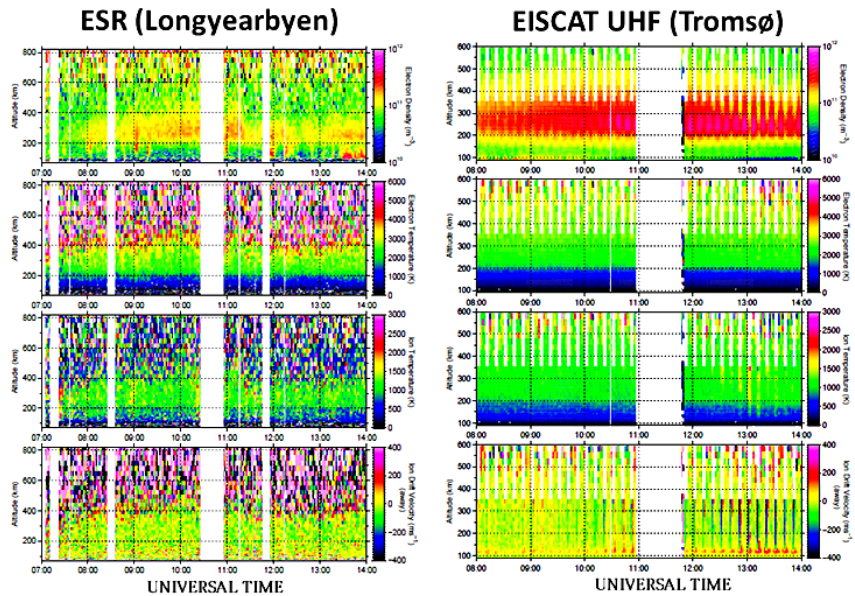
Figure 6. Same as Fig. 5 except for 13 March; observations on the relatively quiet day.